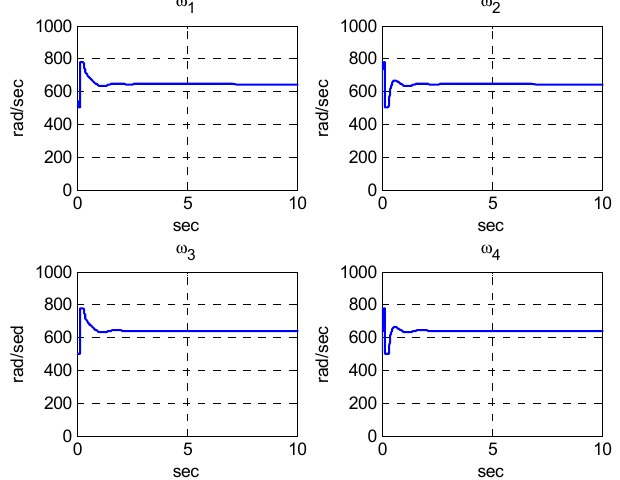
Figure 8. The rotor velocity with variable deviations.